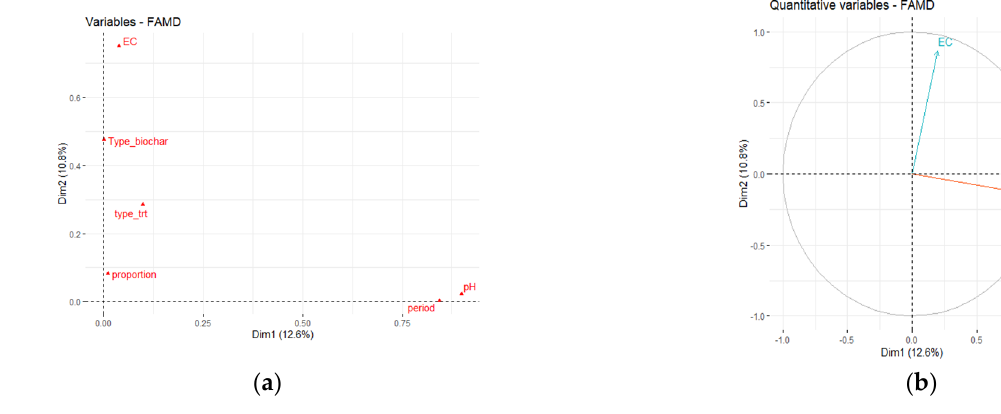
Figure 1. ( a ) Factor analysis of mixed data (FAMD) was used to analyze physicochemical data from Paspalum vaginatum Swartz. Electrical conductivity, pH, type of treatment, period, and proportion are represented as variable groupings. ( b ) Loading plot of P. vaginatum pH and electrical conductivity during three seasons and amended with three biochars.